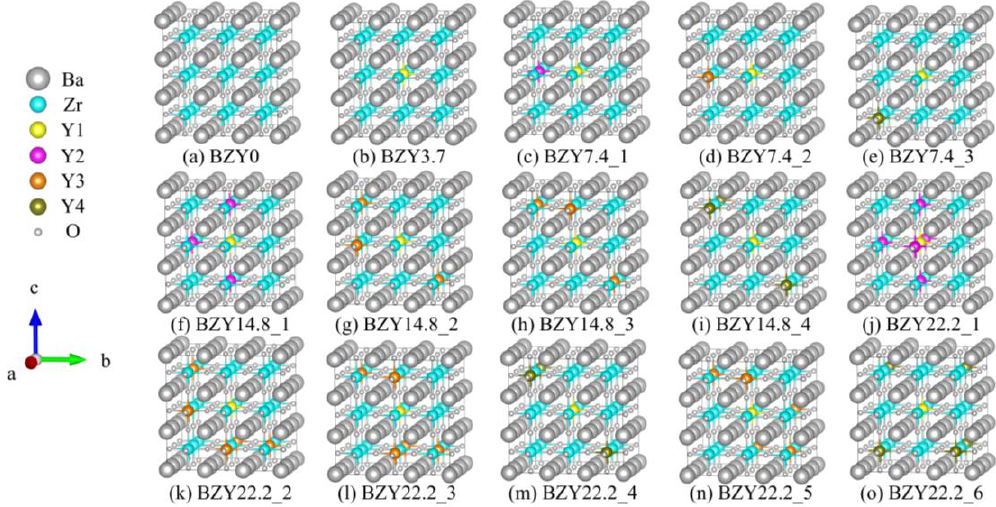
Figure 3. ( a ) Schematic 3 × 3 × 3 supercell structure of BZO. ( b ) Color diagram of B-site atoms according to the doping site distance distribution. The Y1 (yellow B-site atom) is the center, with Y2 (purple B-site atoms) as the nearest neighbor, Y3 (orange B-site atoms) as the next closest neighbor, and Y4 (brown B-site atoms) as the farthest.